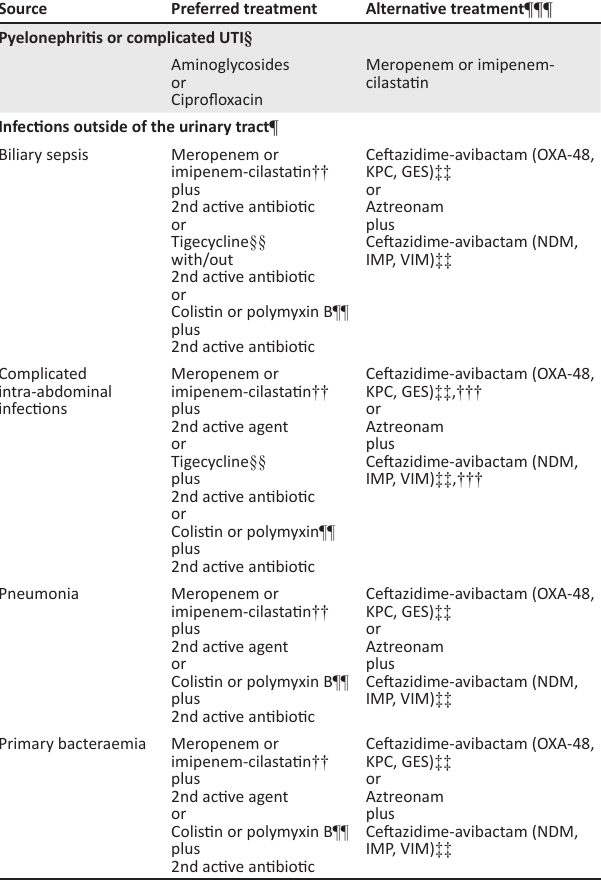
TABLE 5: Recommended intravenous antibiotic dosing and administration schedules for critically ill adult patients (with normal renal function) . † Agent